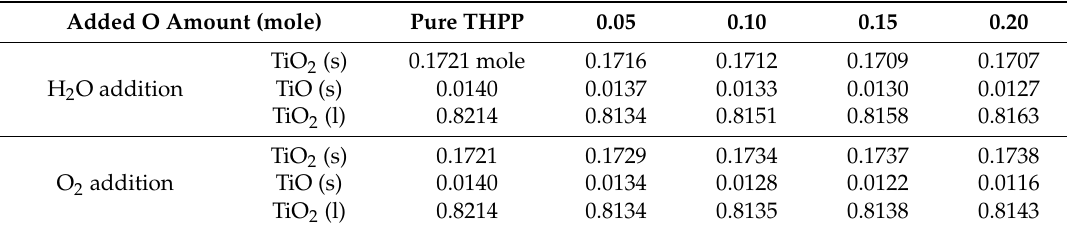
Table 1. Compositional changes in TiO x species determined by equilibrium calculations at the flame temperatures calculated under given conditions for H 2 O and O 2 addition. The initial composition for equilibrium calculation is 1 mol of Ti, 2 moles of H, 0.75 mole of K and Cl, and 3 moles of O plus added moles of O, and the temperature and pressure for equilibrium calculation are the calculated flame temperatures shown in Figures 1 and 2,